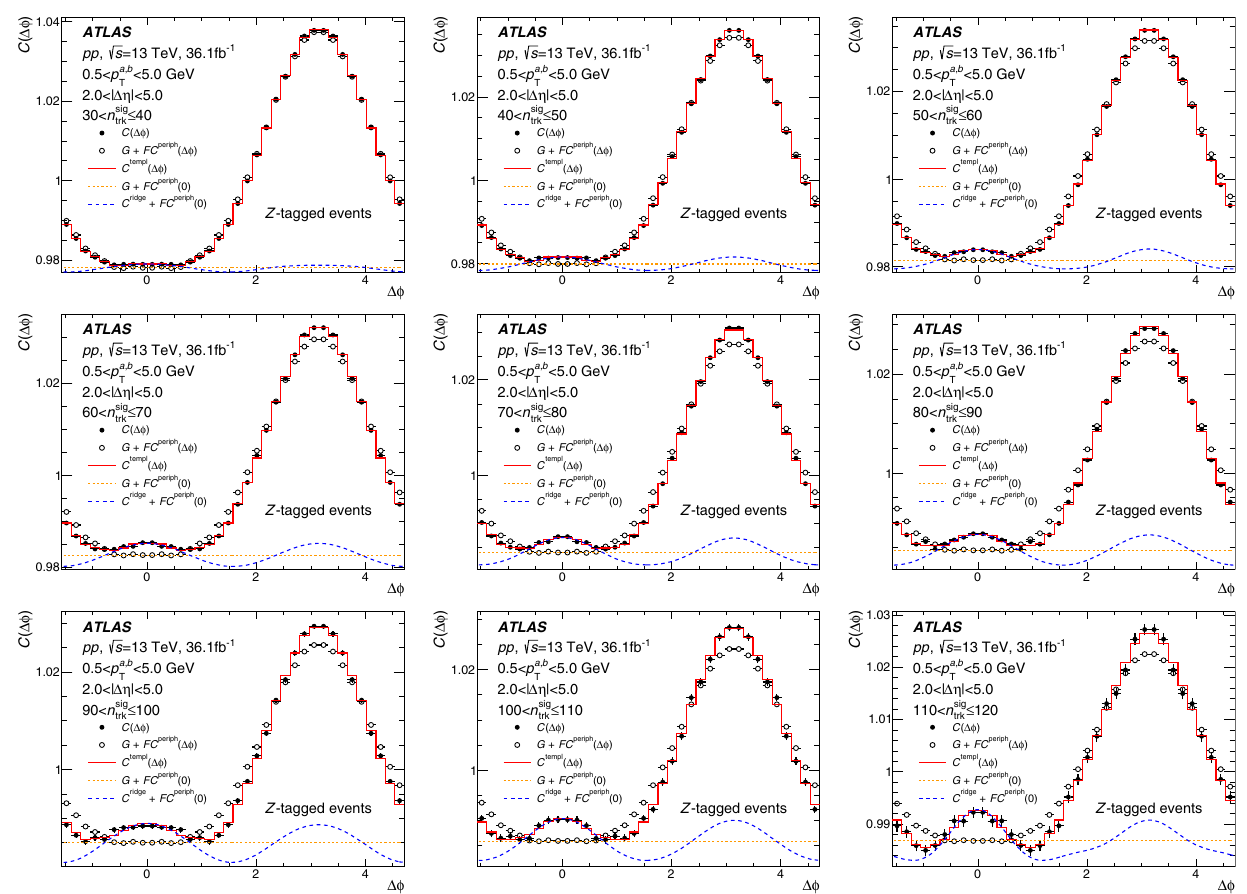
Fig. 8 Template fits to the pile-up-corrected C ((cid:3)φ) in the 13 TeV Z - tagged data. The different panels correspond to different n sig